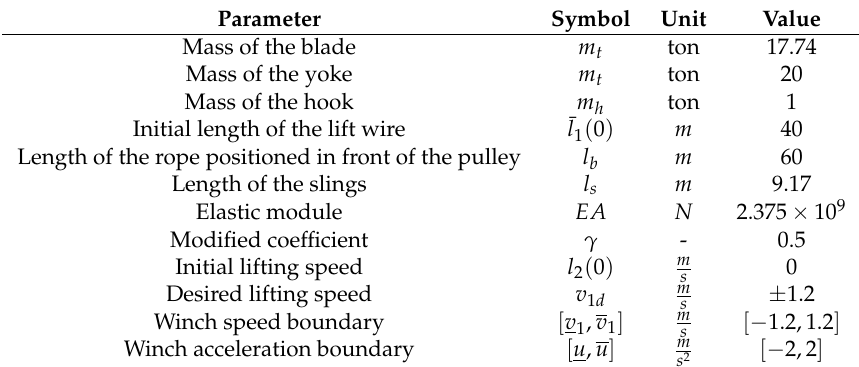
Table 1. Parameters of the single blade installation